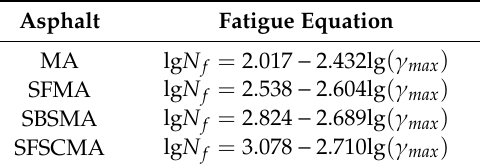
Table 15. Asphalt fatigue